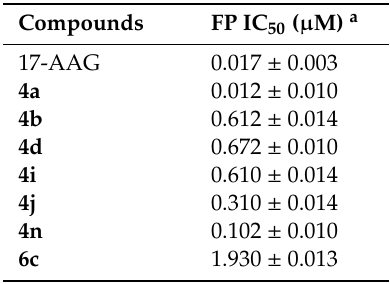
Table 3. FP activities on Hsp90 of selected 2-aryl